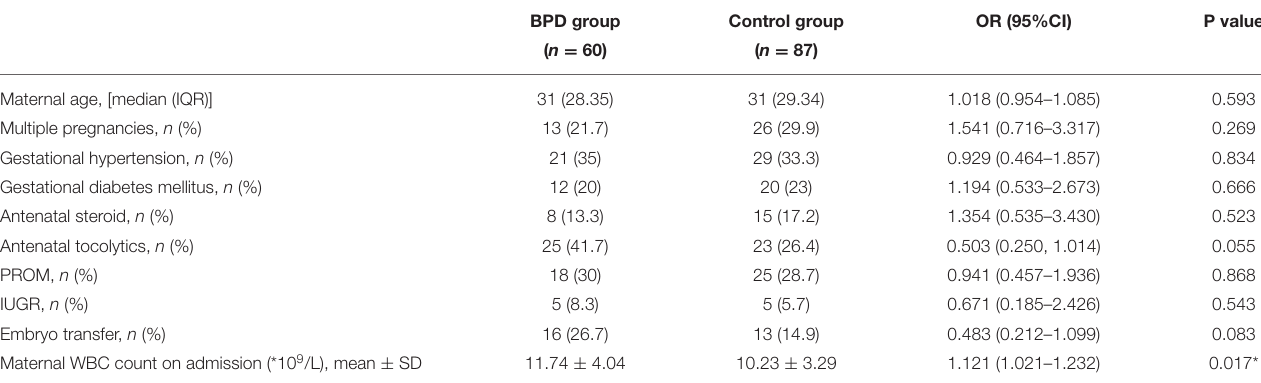
TABLE 2 | Univariate regression analysis of perinatal factors of infants With BPD and controls.